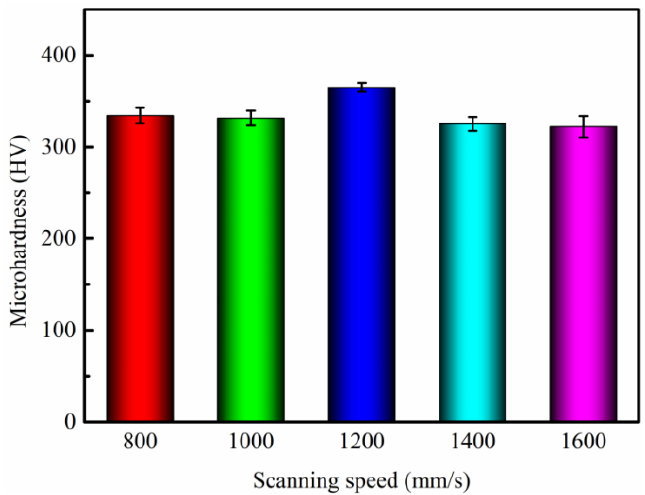
Figure 9. Influence of different scanning speeds on the microhardness of K418.